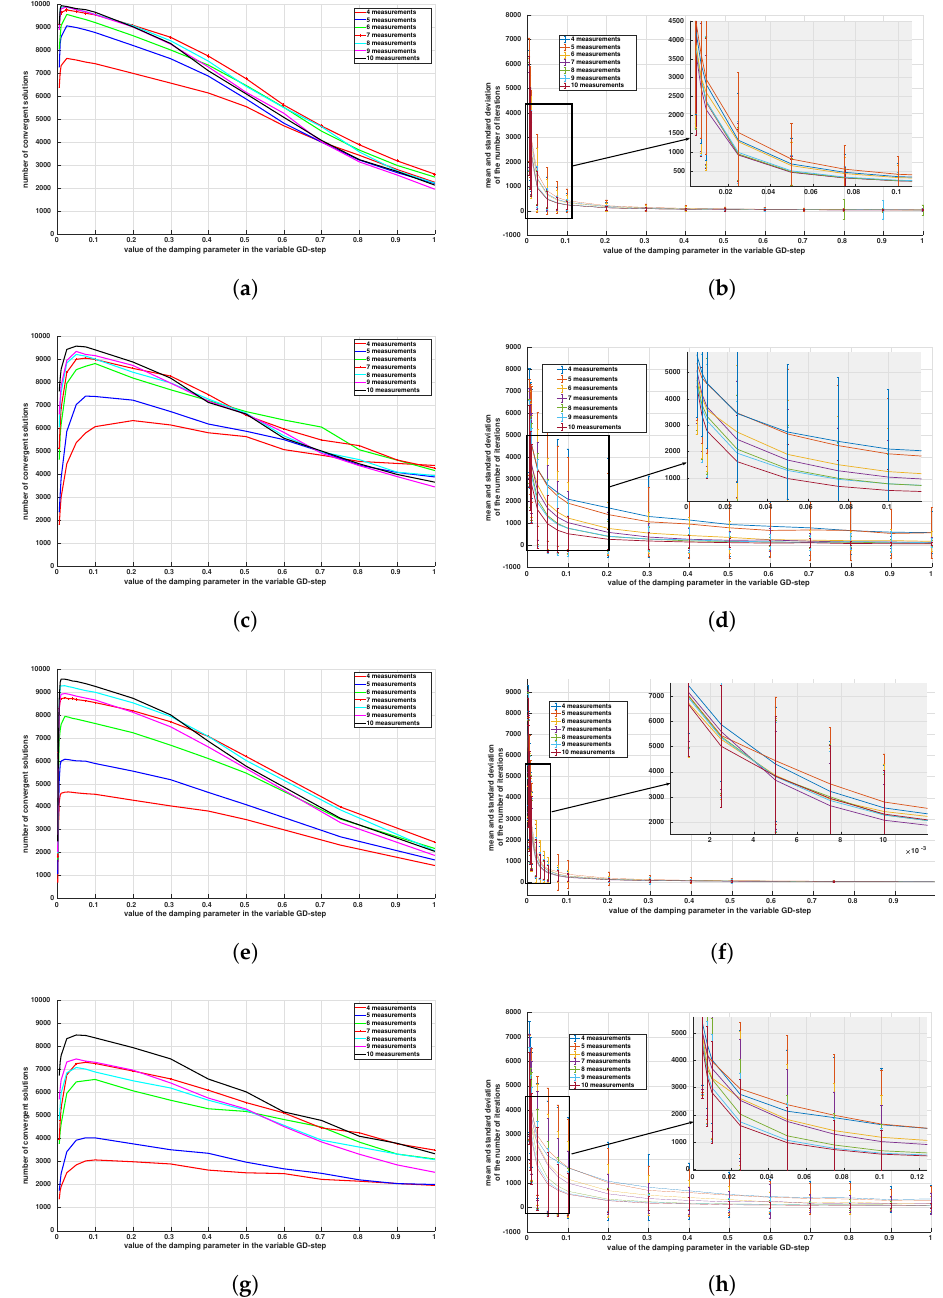
Figure 6. Convergence results ( left column ) with the mean and standard deviations of the number of iterations until convergence ( right column ) over 10,000 simulations of the GD using variable- step descent as a function of the damping parameter, for estimation problems (3)–(6), with and without positioning and measurement error models and by varying the number of neighboring nodes from 4 to 10. ( a ) Problem (3) w/o errors; ( b ) Problem (3) w/o errors; ( c ) Problem (4) w/o errors; ( d ) Problem (4) w/o errors; ( e ) Problem (5) w/errors; ( f ) Problem (5) w/errors; ( g ) Problem (6) w/errors; ( h ) Problem (6)